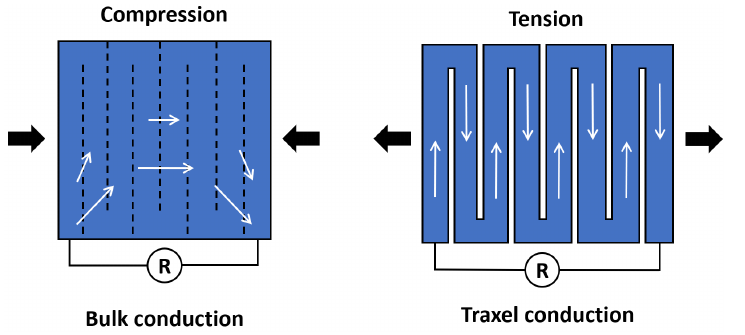
Figure 30. The principle of constriction-resistance strain sensor. The sensing principle makes use of the large resistance change going from bulk conduction to traxel conduction upon straining of the gaps between the traxels. The white arrows indicate the current flow through the sensor, whereas the black arrows indicate the force applied on the